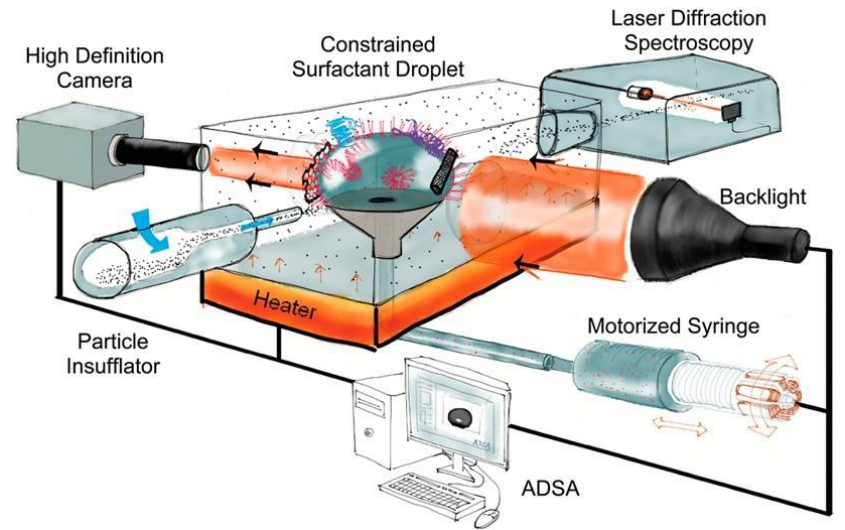
Figure 5. Sketch of the typical configuration of a constrained drop surfactometer. Reprinted from Valle et al. [70] , with permission from ACS, Copyright 2015.